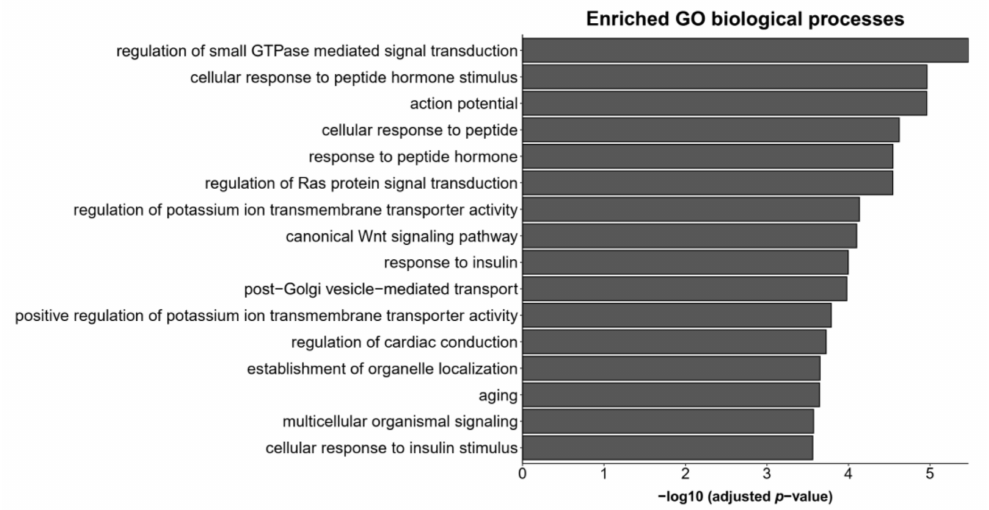
Figure 3. Gene ontology biological processes enriched by the list of genes reversed by all antipsy- chotic